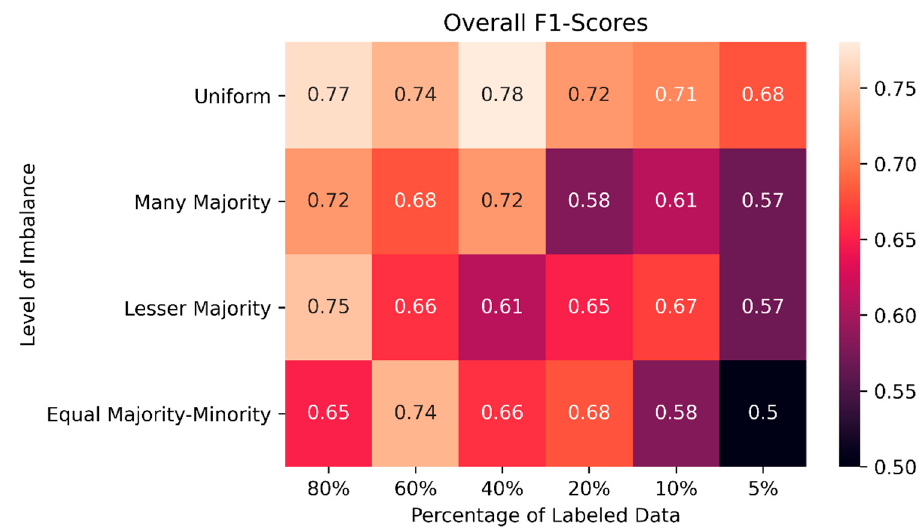
Figure 5. Overall F1-score for varied labeled samples and 4 levels of imbalance.